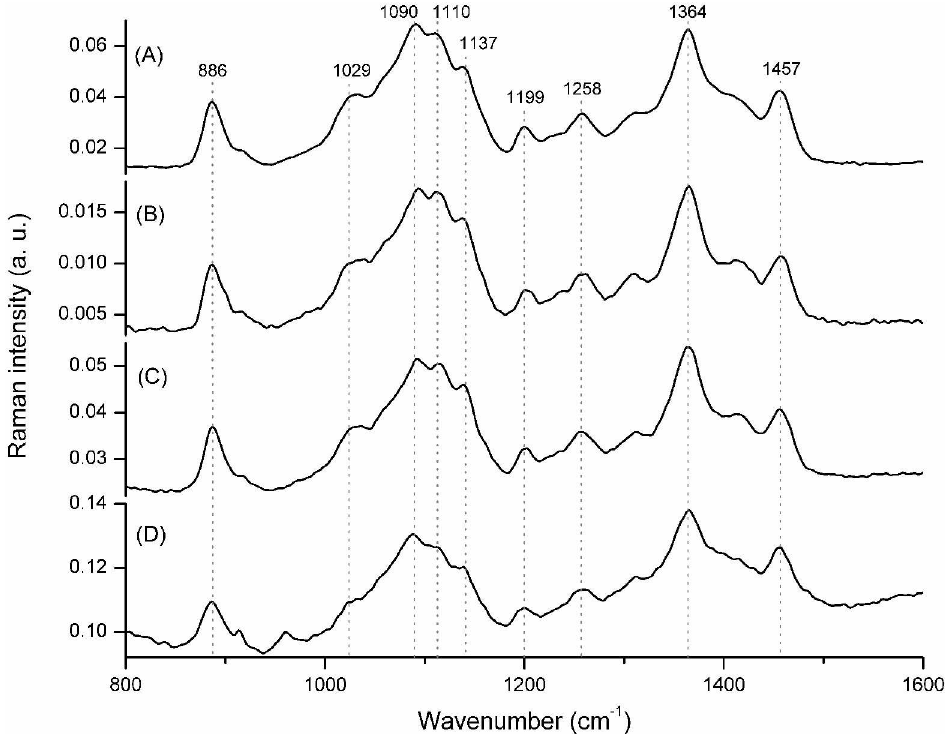
Fig 1. FT-Raman spectra of: (A) commercial curdlan, (B) pre-gelled commercialcurdlan, (C) curdlan produced by Agrobacterium sp. IFO 13140 (pre-gellation method), (D) curdlan produced by Agrobacterium sp. IFO 13140 (precipitation method). The dotted lines show the characteristic peaks of the samples.